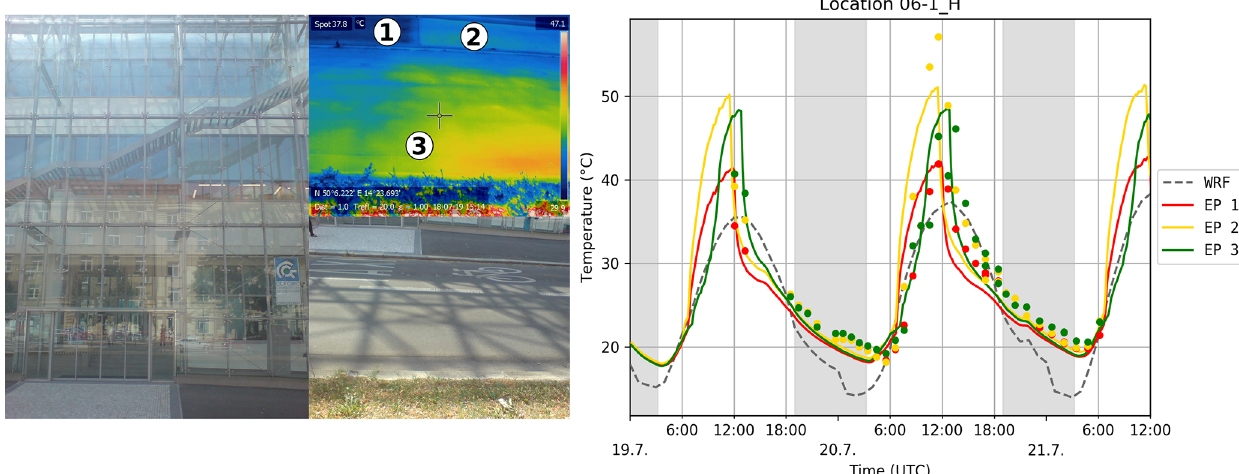
Figure 17. Location 06-1: the left panel shows IR and RGB photos of the observation location with placement of the evaluation points, and the right panel shows observed (dots) and modelled (lines) surface temperature for the summer e2 episode. The grey dashed line shows the corresponding WRF skin layer temperature. The grey areas denote night-time.